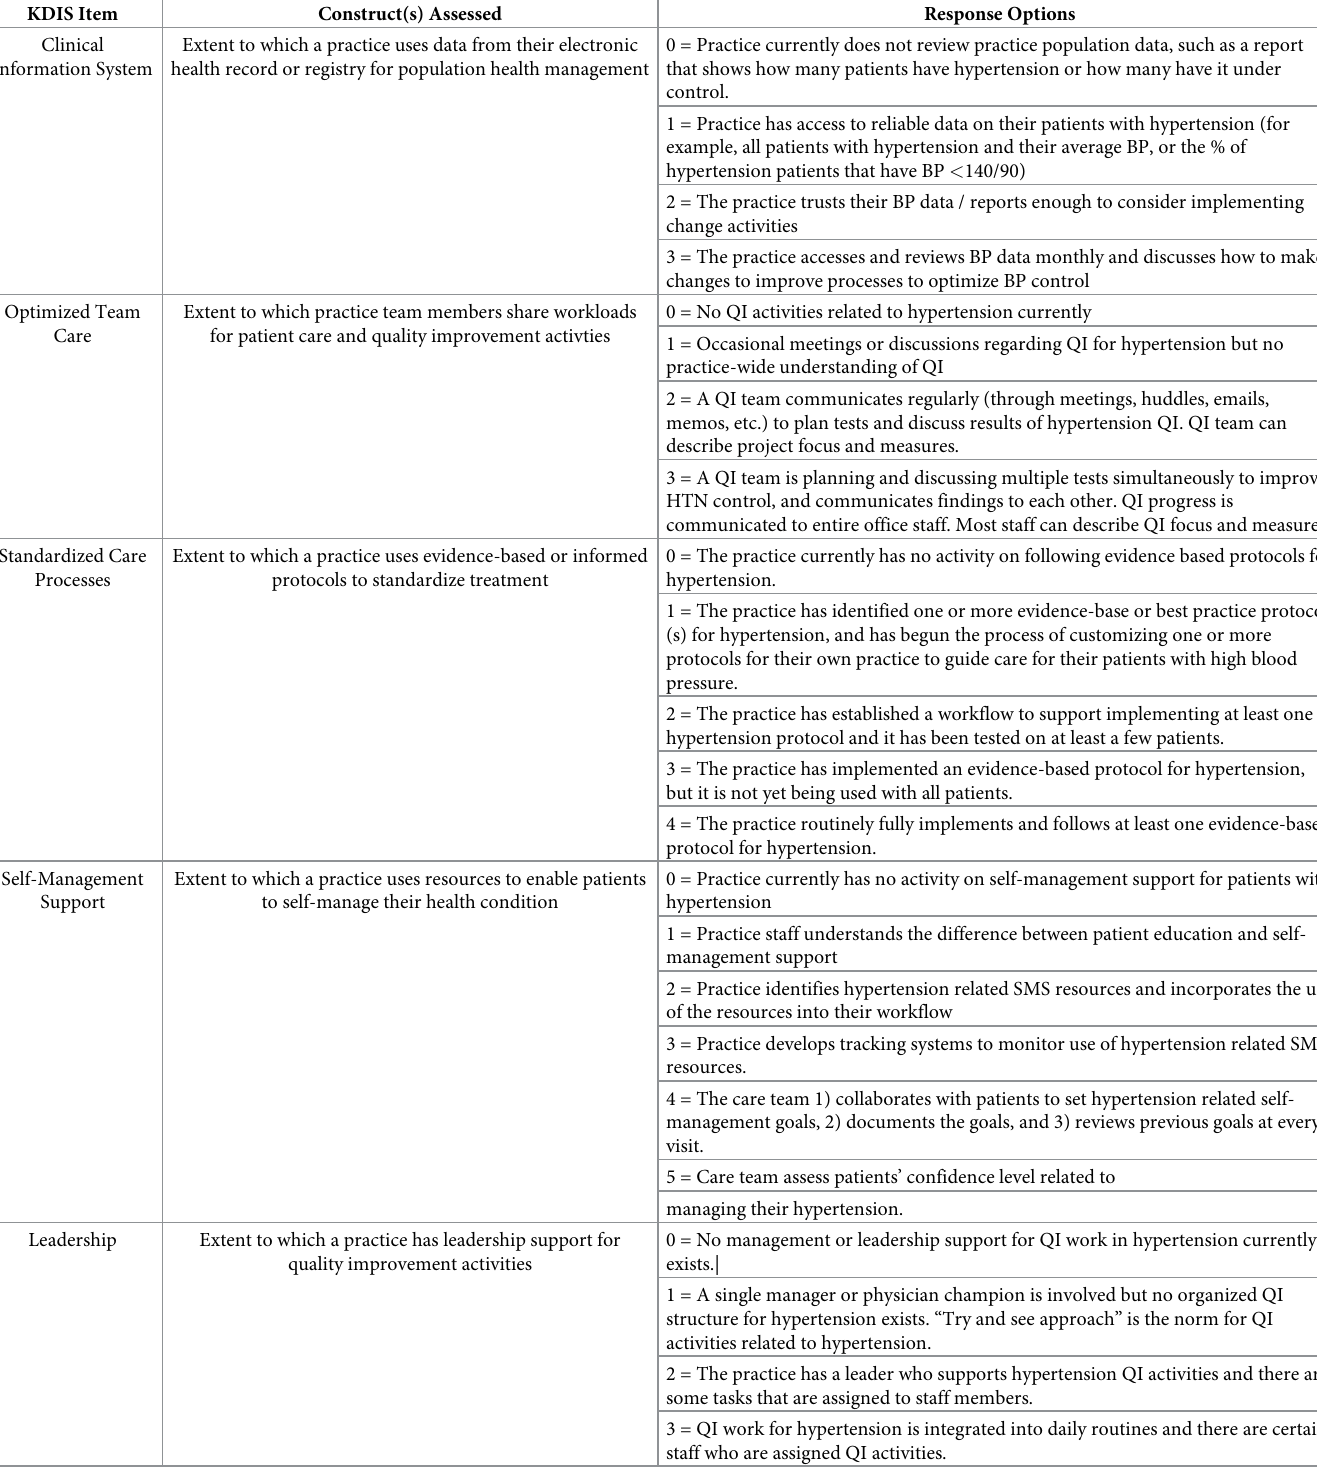
Table 2. KDIS items and response